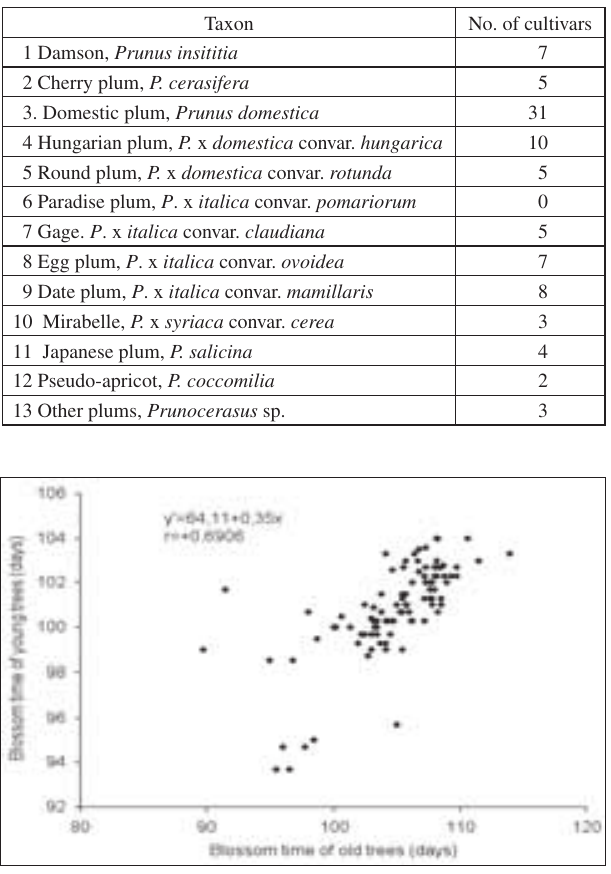
Table 7. Taxonomic distribution of measured plum